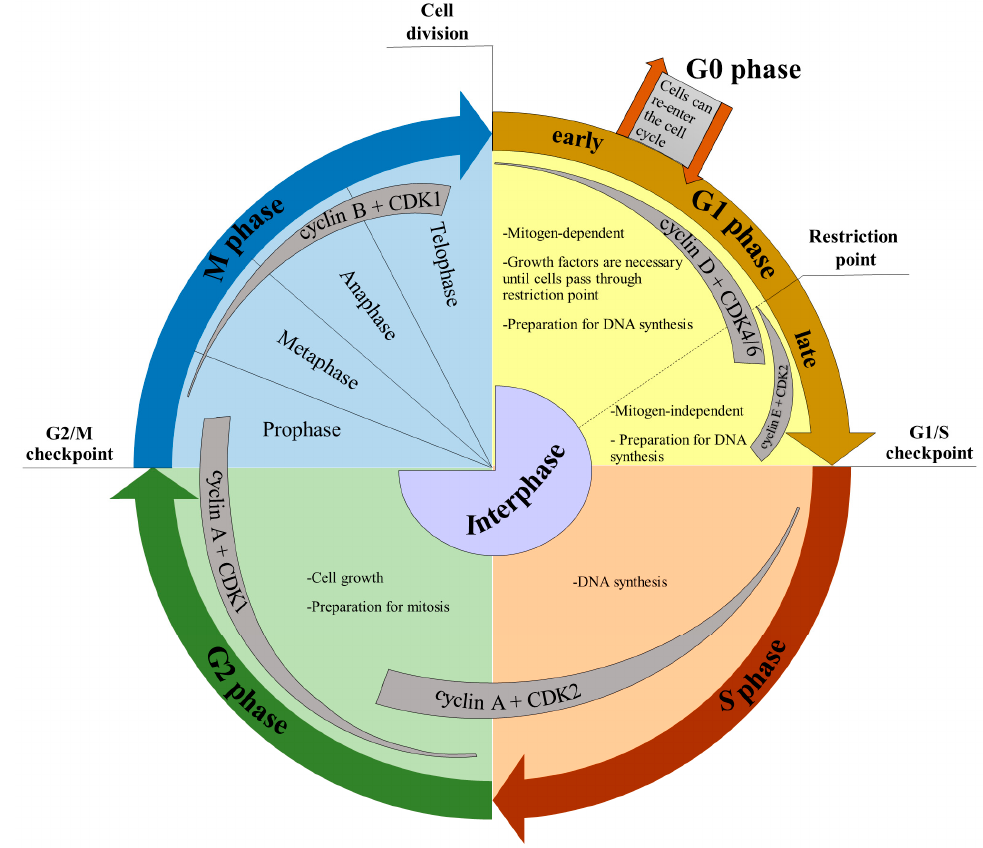
Figure 2. Schema of the cell cycle.